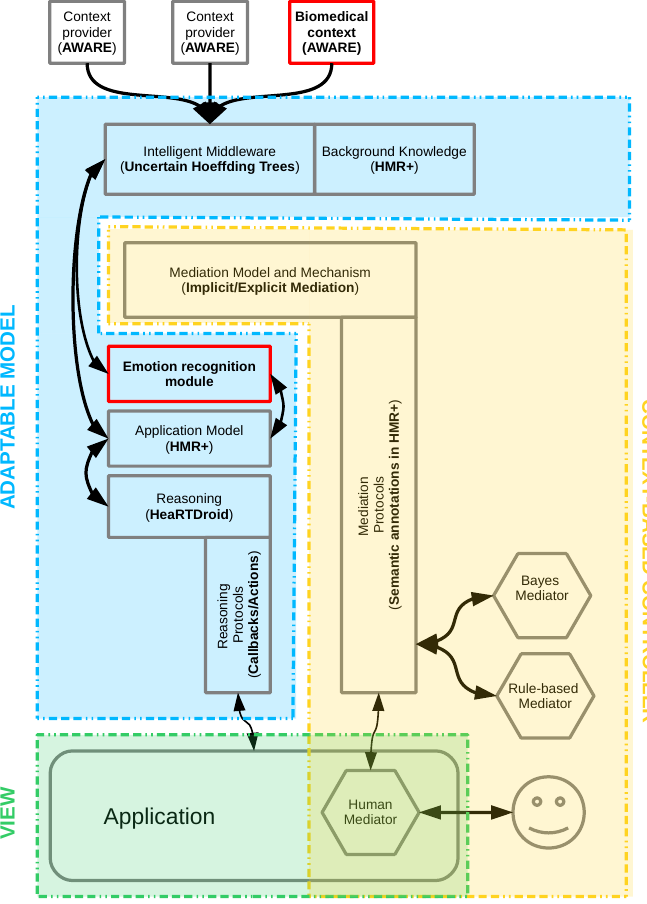
Figure 14. AfCAI (Affective Computing with Context Awareness for Ambient Intelligence) platform architecture